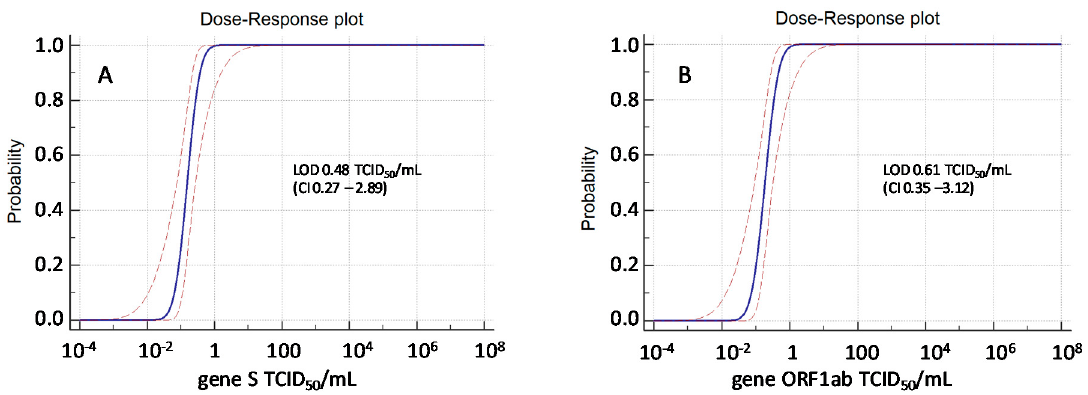
Figure 1. Probit analysis of Simplexa Covid-19 Direct Assay applied to OF samples spiked with virus preparation both for S gene ( A ) and ORF1ab gene ( B ).